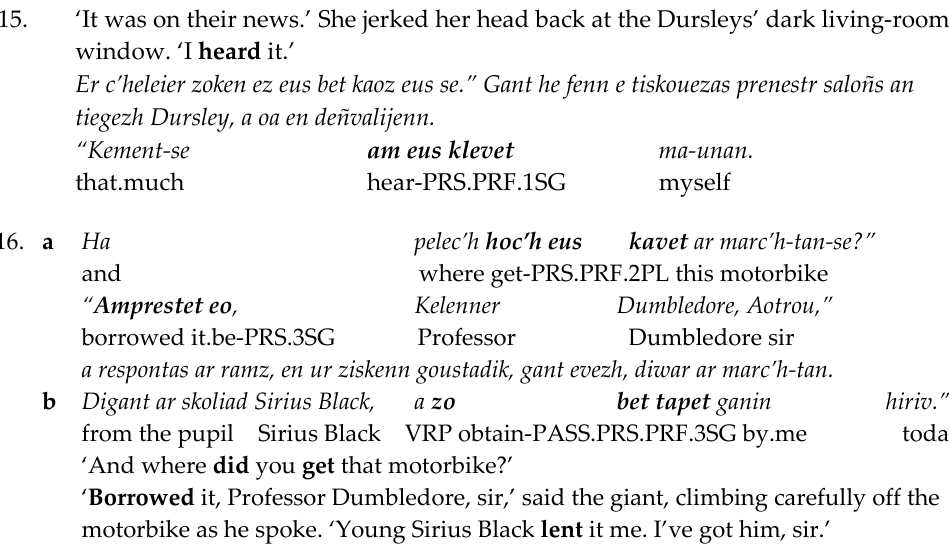
Table 2. Breakdown of perfects and PRS.PRF types in Breton, in corpus B. Perfect Type: